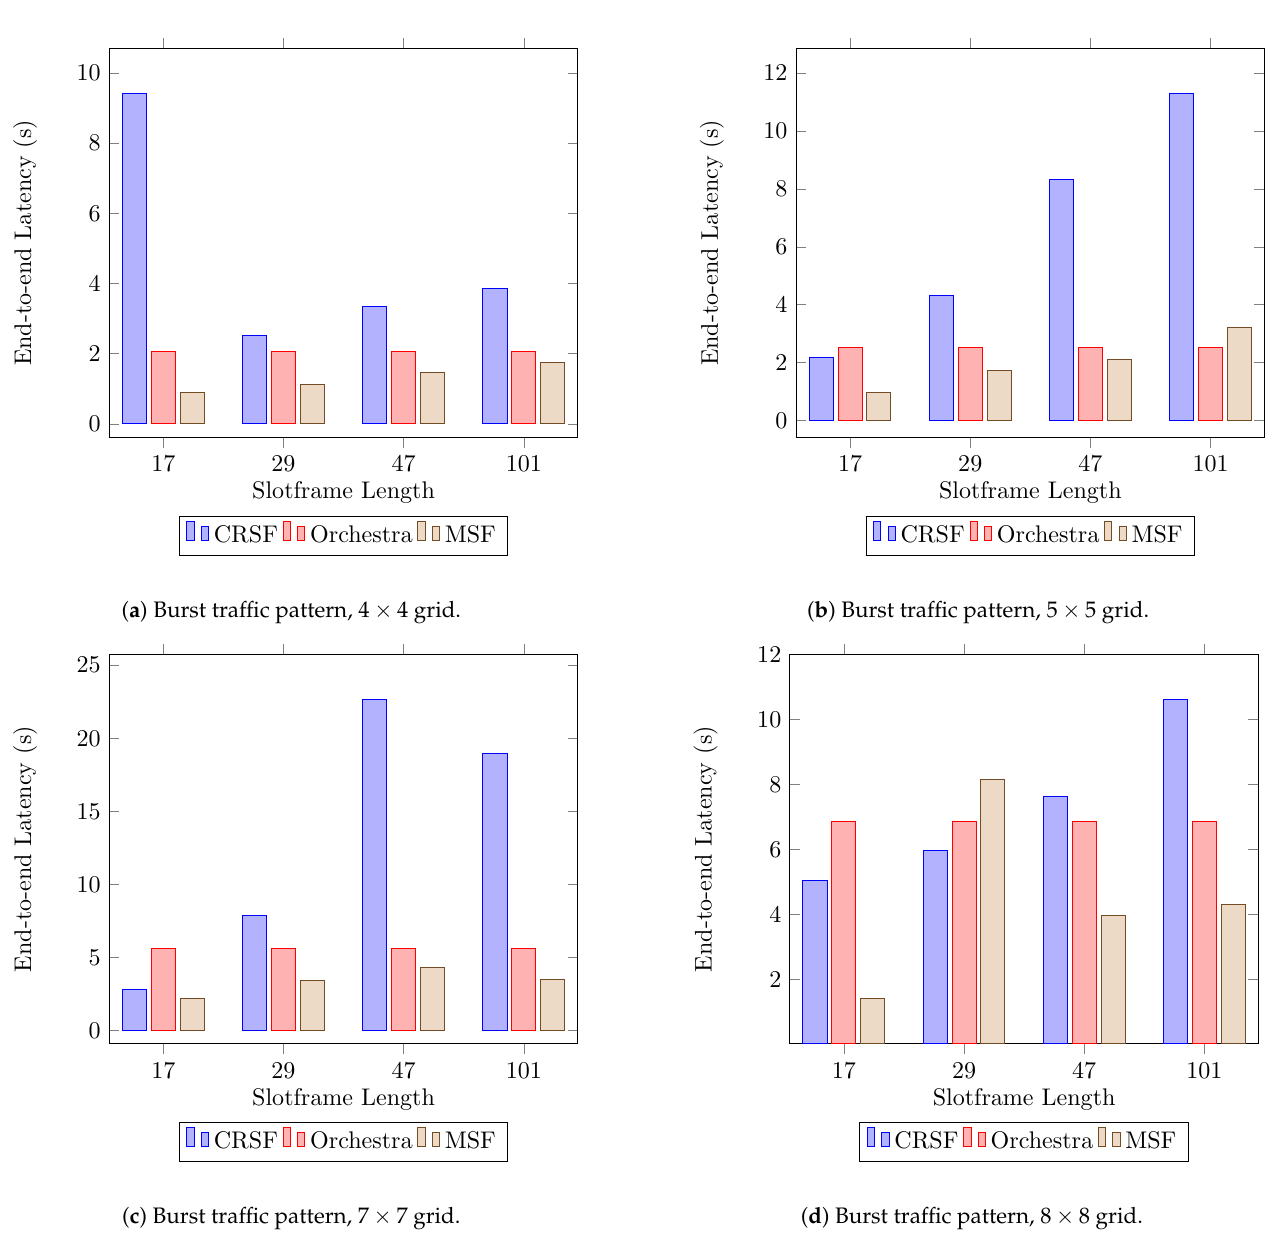
( c ) Burst traffic pattern, 7 × 7 grid. ( d ) Burst traffic pattern, 8 × 8 grid. Figure 10. Average end-to-end latency performance using a burst traffic pattern. Lower is better. Finally, the RDC indicator for burst traffic patterns is shown in Figure 11, where the CRSF stays under 40% in deployments of 4 × 4 (Figure 11a) and 5 × 5 (Figure 11b) and up to 63.82% in 7 × 7 (Figure 11c) and 8 × 8 (Figure 11d). The CRSF outperforms Orchestra in all scenarios by a large margin (see Table A7 in Appendix A for the supplementary data). The CRSF shows a similar performance when compared to the MSF as the number of nodes becomes larger. This behavior is similar to the measured results obtained in tests with periodic traffic